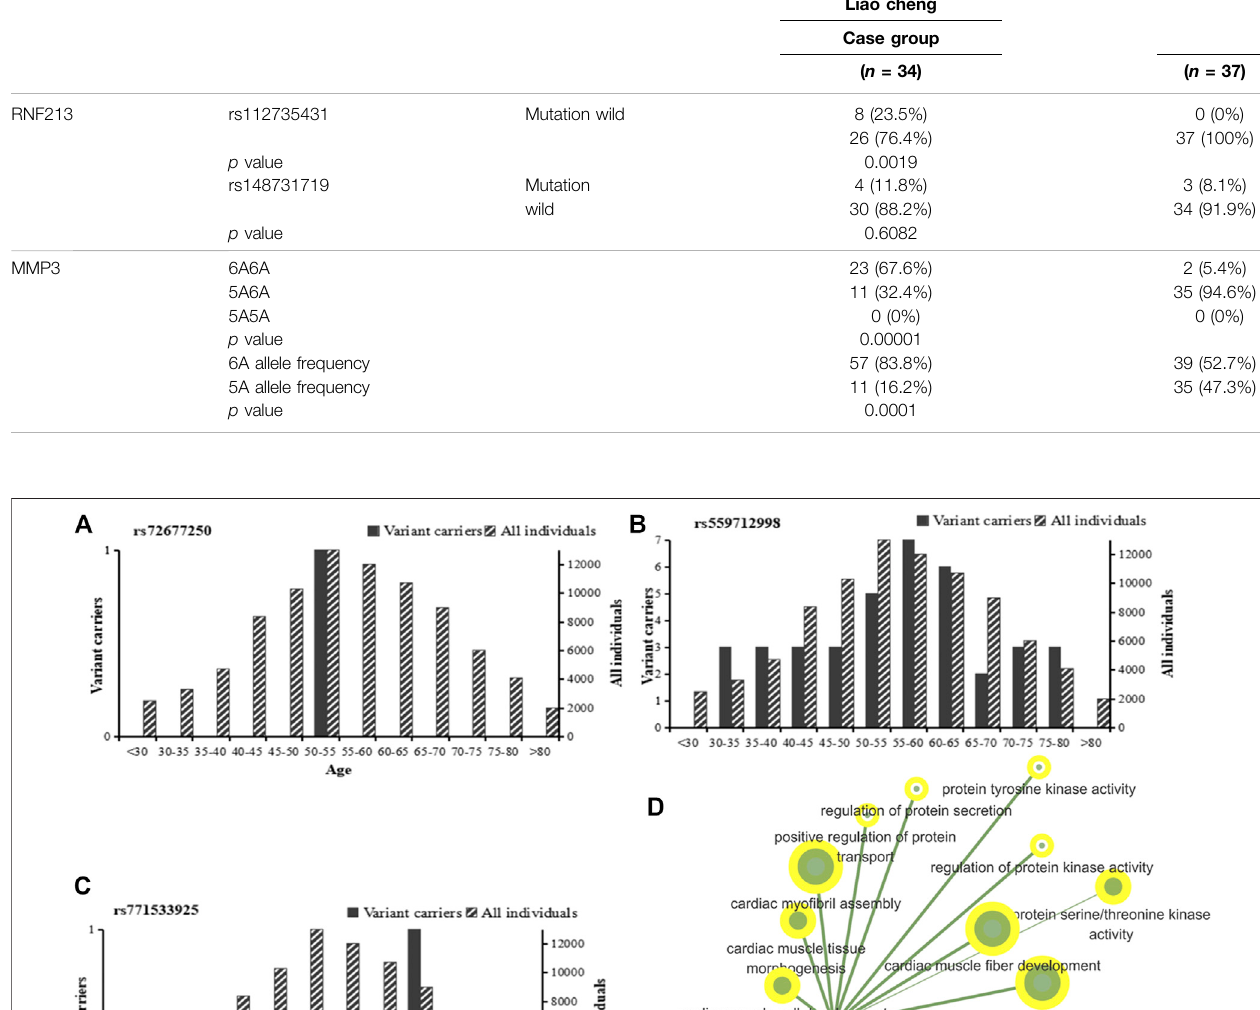
Frontiers in Molecular Biosciences |